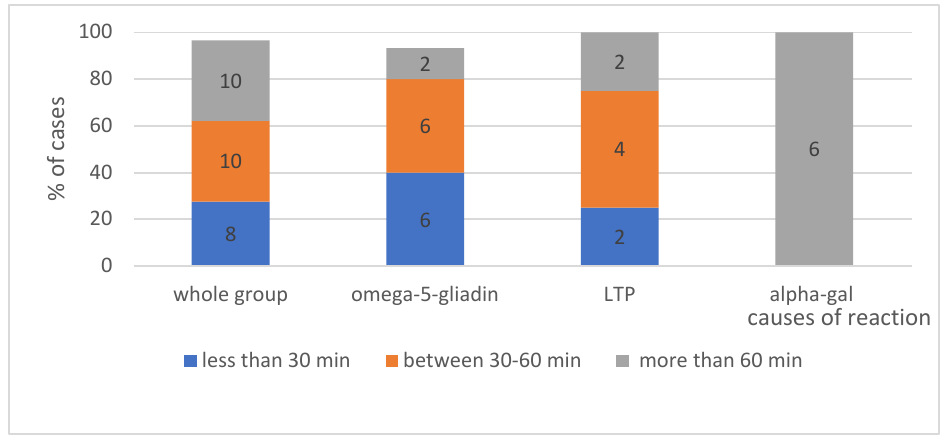
Figure 6. The time interval from exposure to the cause until the reaction occurs. Absolute values of numbers of patients are given in the diagram.